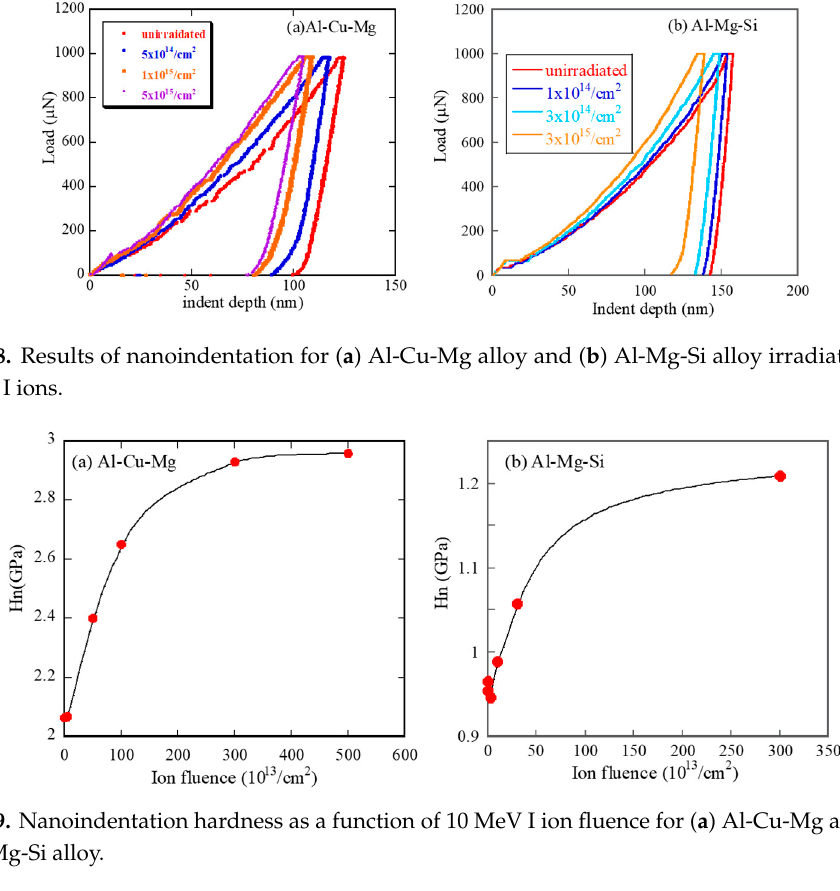
Figure 7. Change in Vickers hardness as a function of deposited energy density by elastic collisions for ( a ) Al-Cu-Mg alloy and ( b ) Al-Mg-Si alloy.